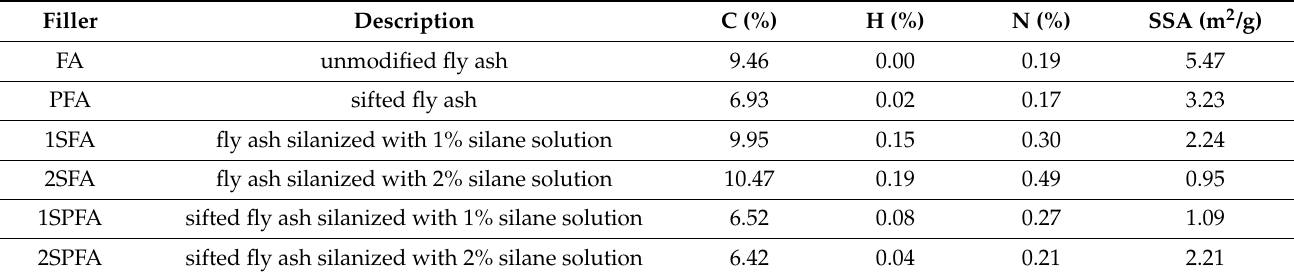
Table 1. Elemental analysis of C, H, N and SSA of fillers.